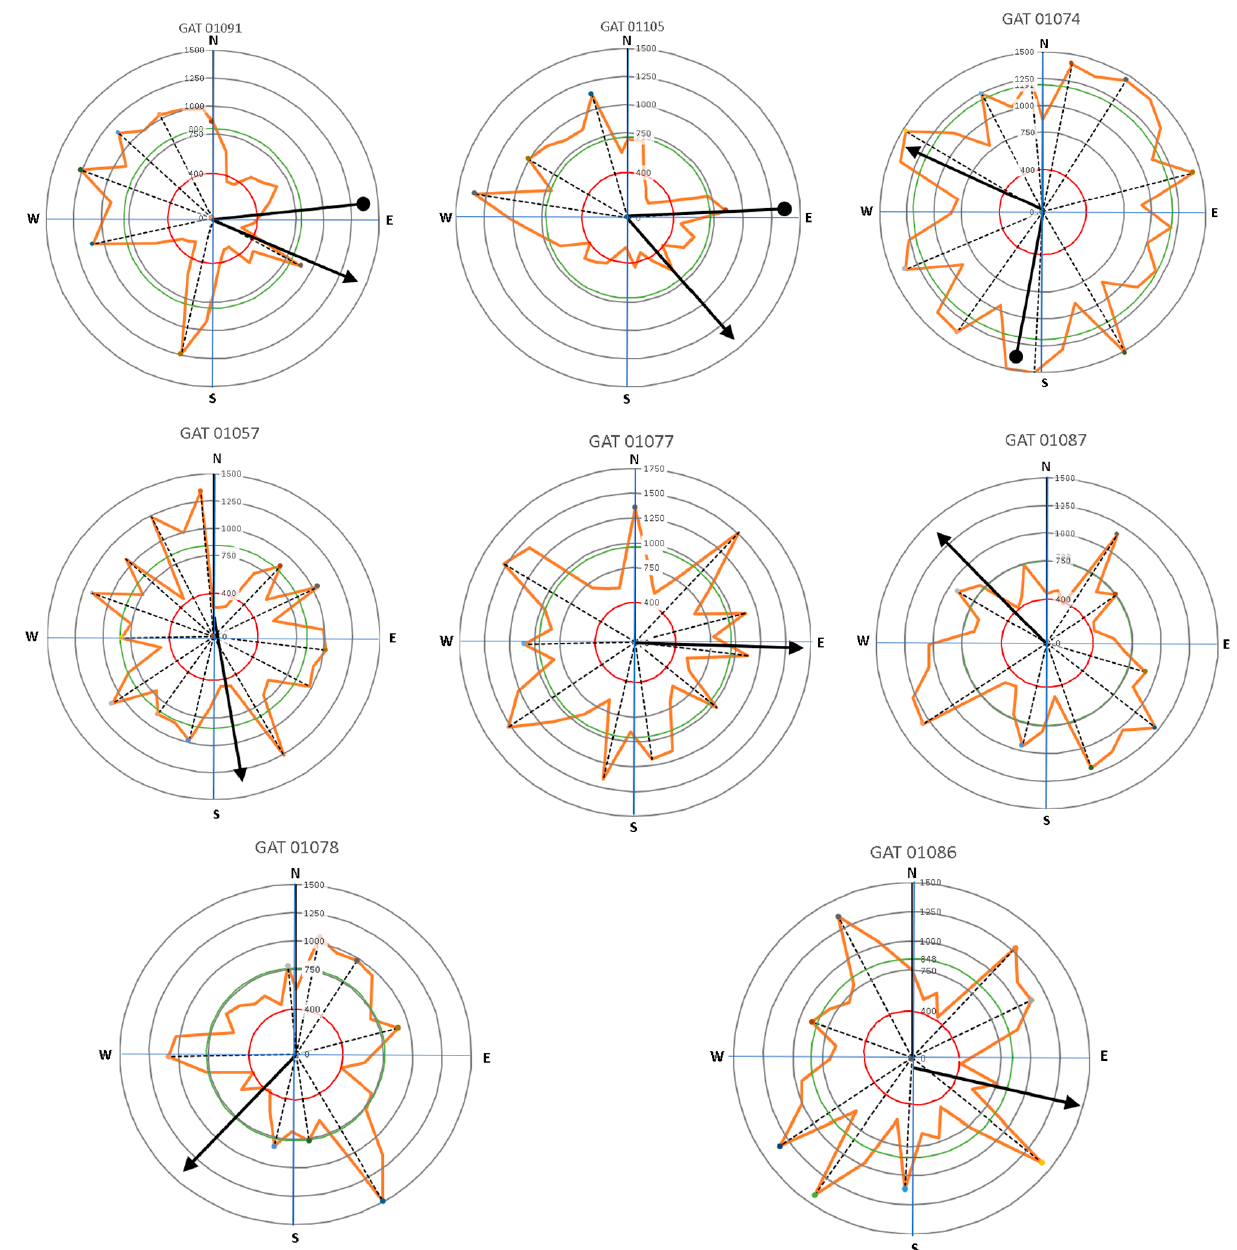
Figure 9. The direction of leaning for Samanea saman trees (circle-head line) and crown develop- ment (arrow-head line) in relation to lateral root distribution with the main lateral roots (dash lines).